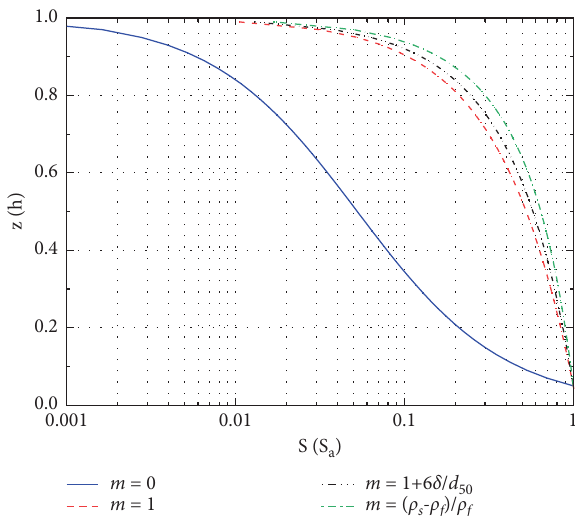
Figure 1: Comparison of the vertical relative distribution of sediment concentration.